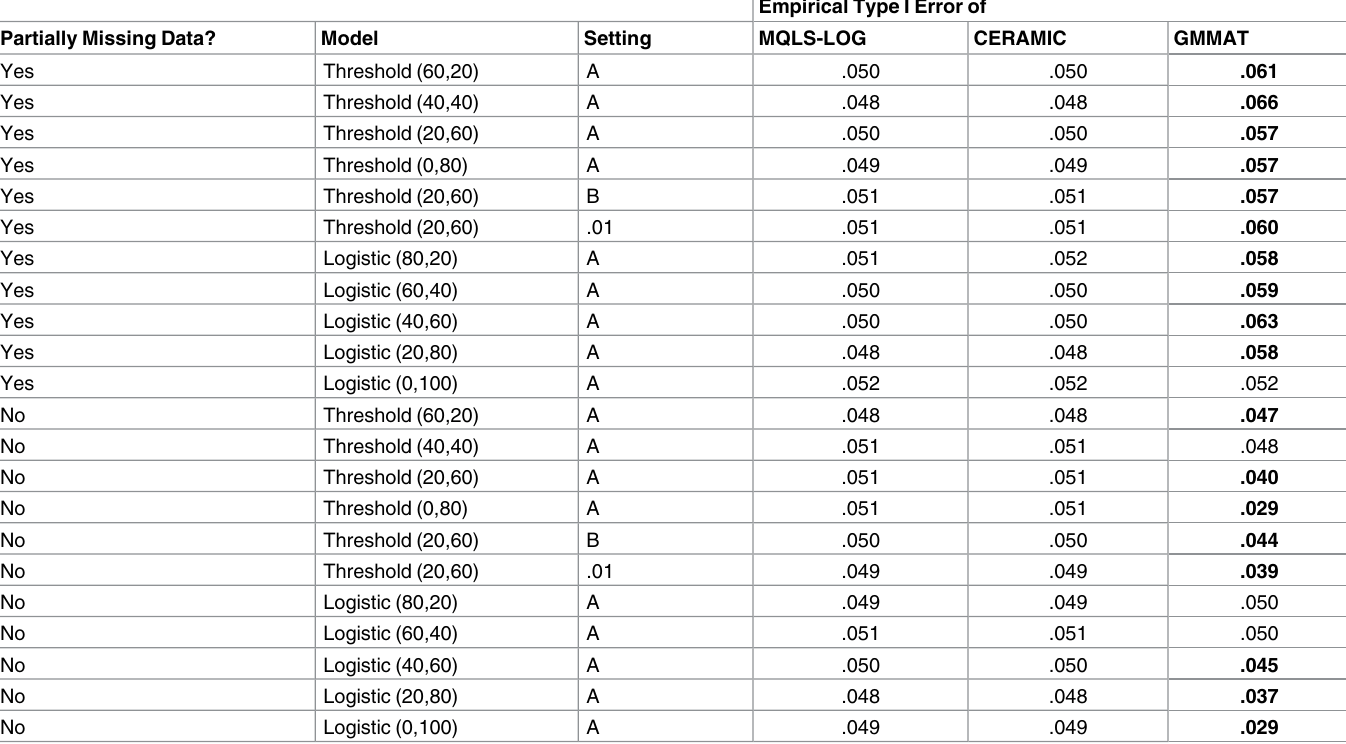
Empirical Type I Error